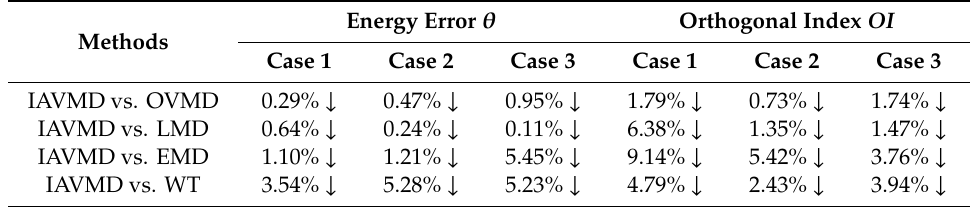
Table 6. The percentage di ff erences of the IAVMD with respect to other approaches in the experiment